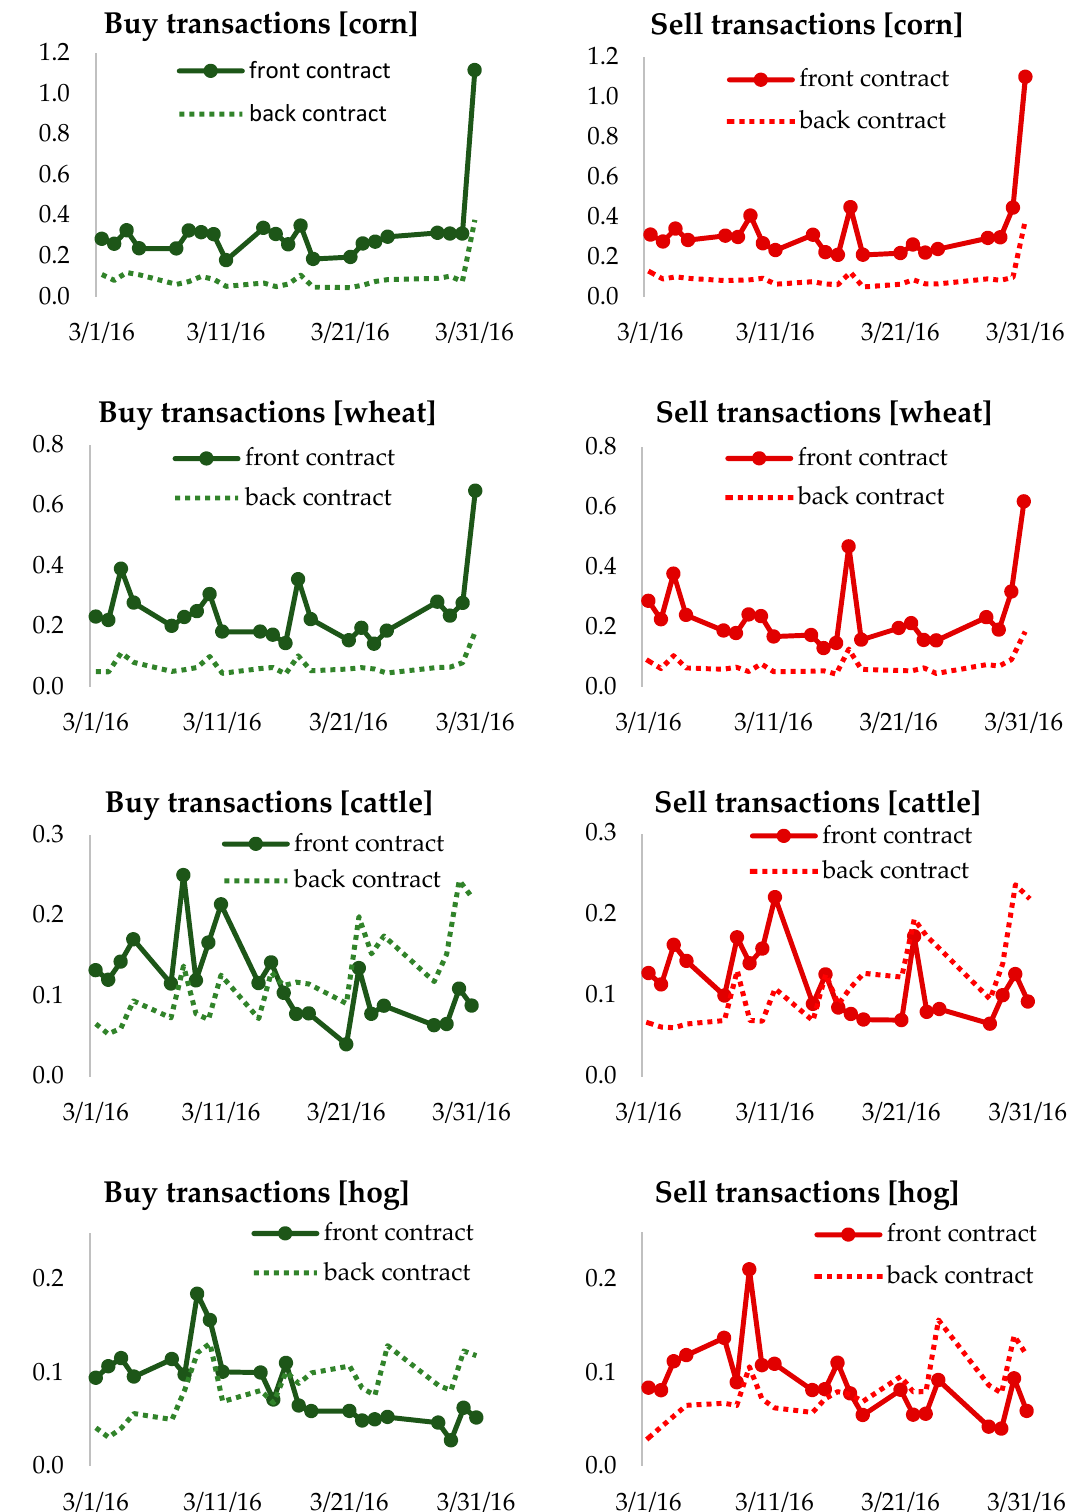
Figure 2. Evolution of average intensities ( y -axis) in both buy and sell transactions for corn, wheat, live cattle, and lean hog in March 2016.